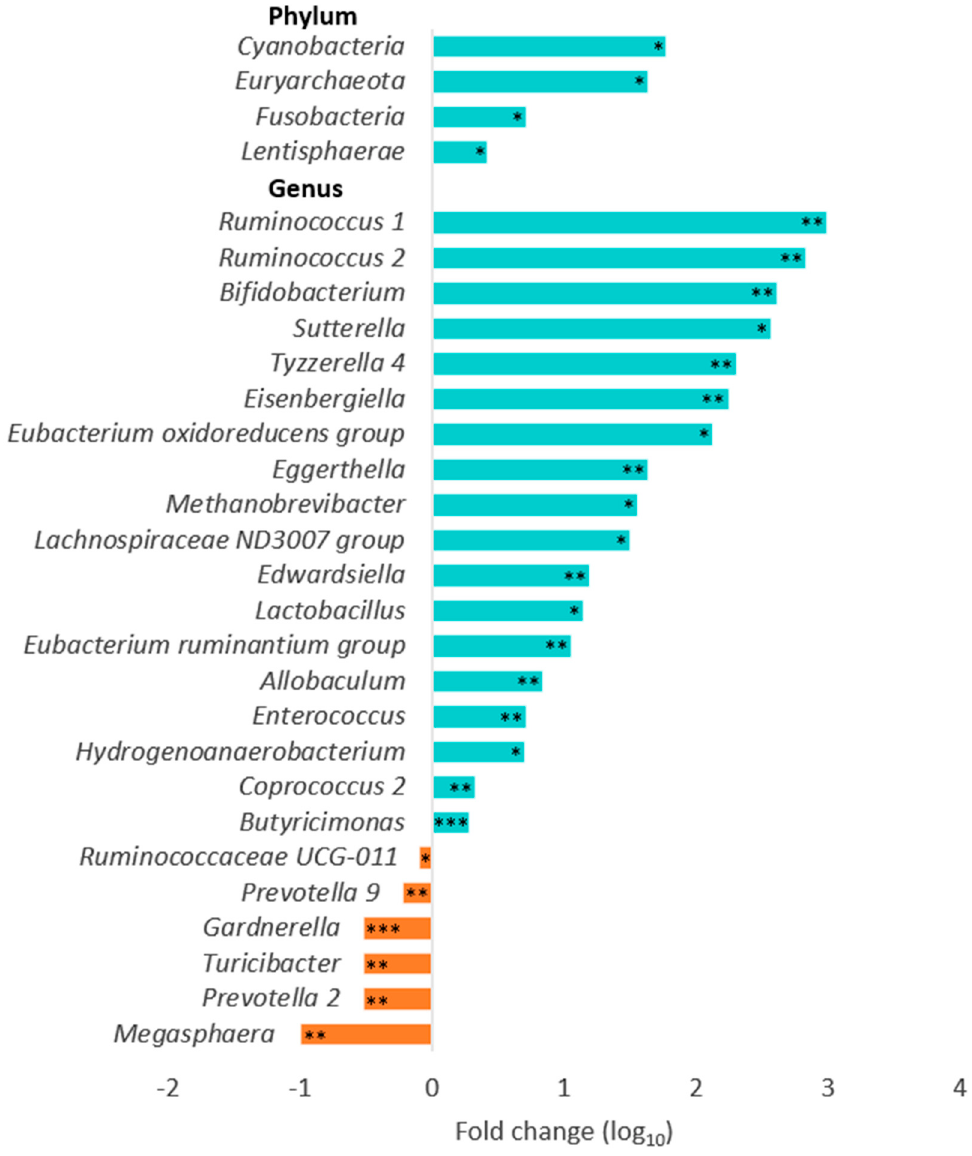
Figure 2. Changes in the relative microbial abundance in the gut after synbiotic intervention. * p < 0.05, ** p < 0.01, *** p < 0.001, as compared with the placebo group at the end of the trial.